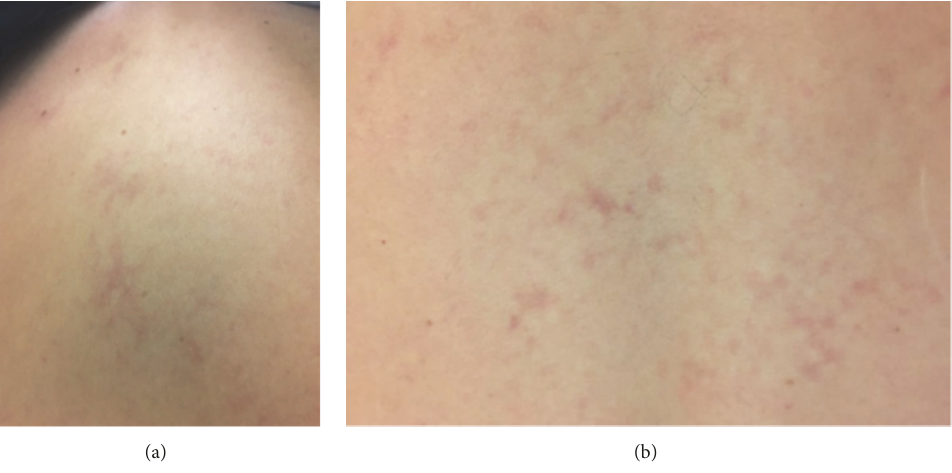
Figure 1: Lacy, purplish rash on the upper and lower